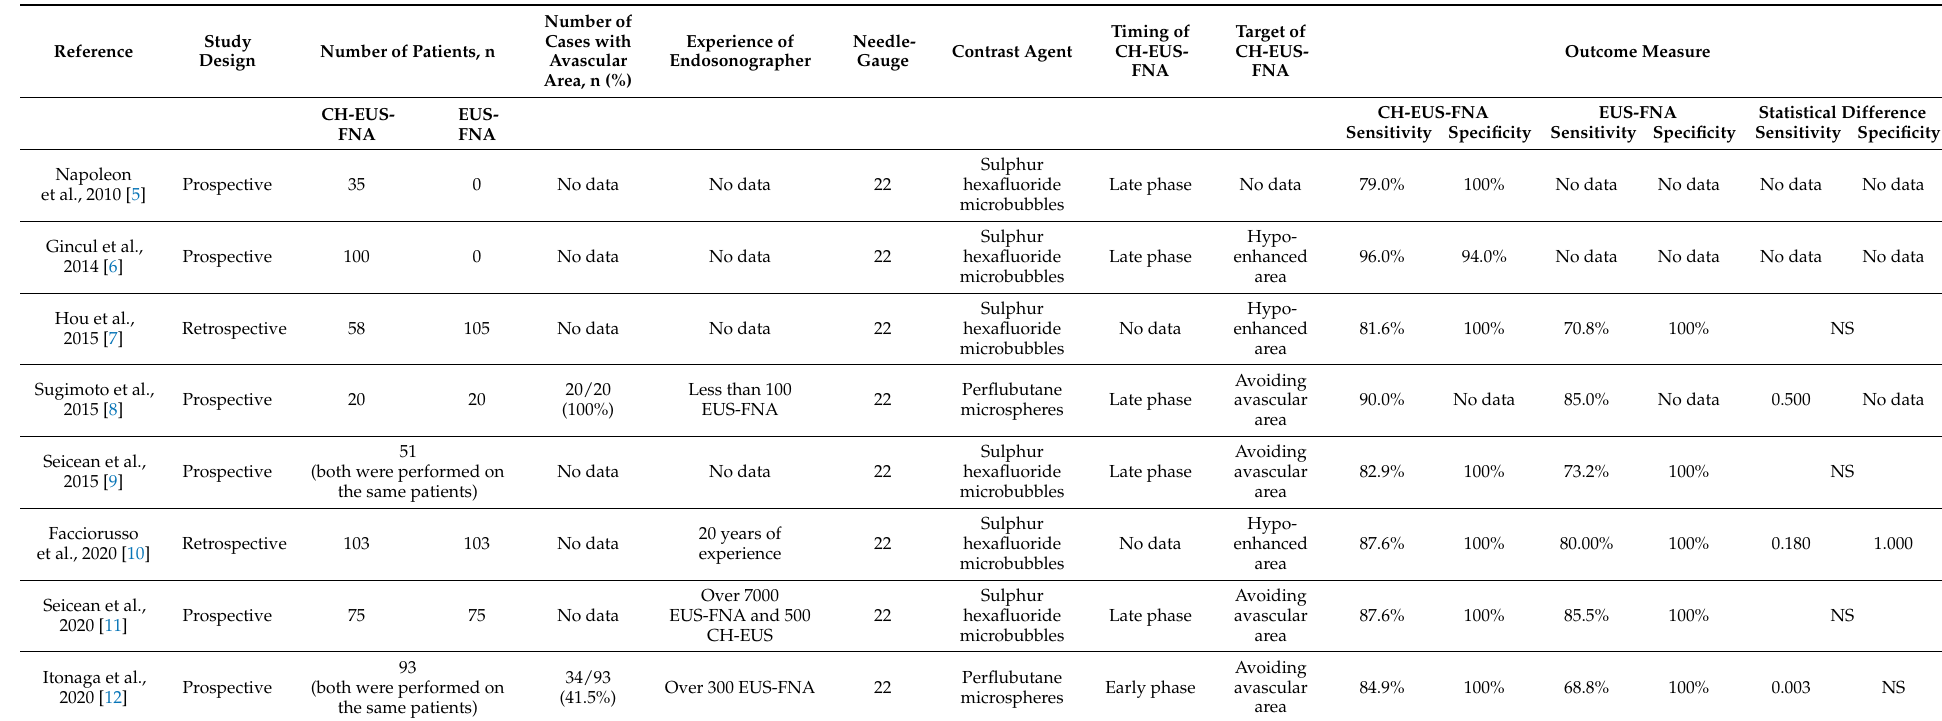
Table 1. Studies on CH-EUS-FNA for pancreatic